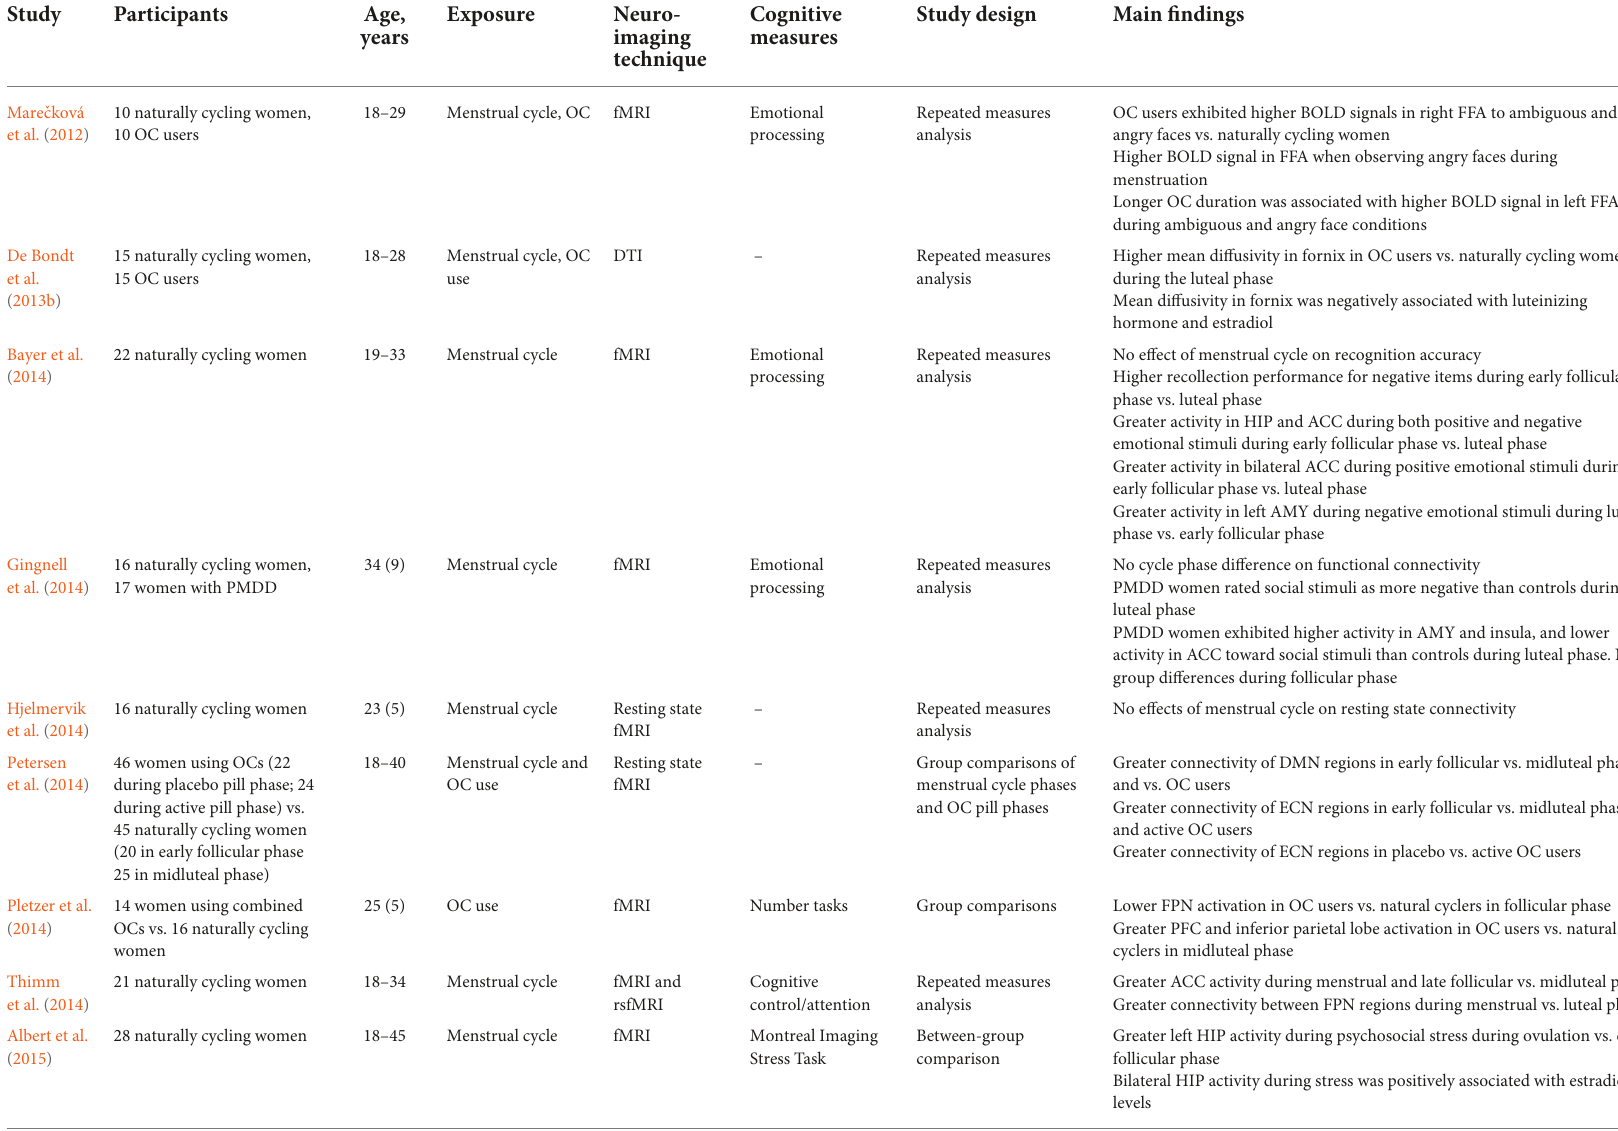
TABLE 1 Summary of studies investigating the effects of the menstrual cycle and of use of hormonal contraceptives on neuroimaging